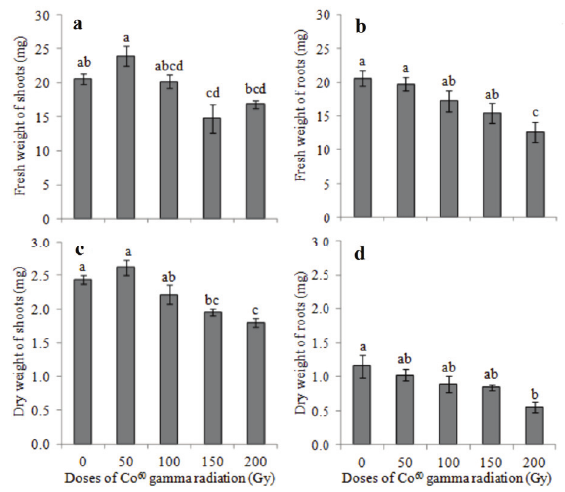
Figure 4 - The fresh weight of shoots ( a ) and roots ( b ) and the dry weight of shoots ( c ) and roots ( d ) of castor bean seedlings exposed to different doses of Co 60 gamma radiation and evaluated after 21 days. Means followed by diff erent letters diff er by Tukey’s test (P<0.05). Bars represent the standard error of the mean of four